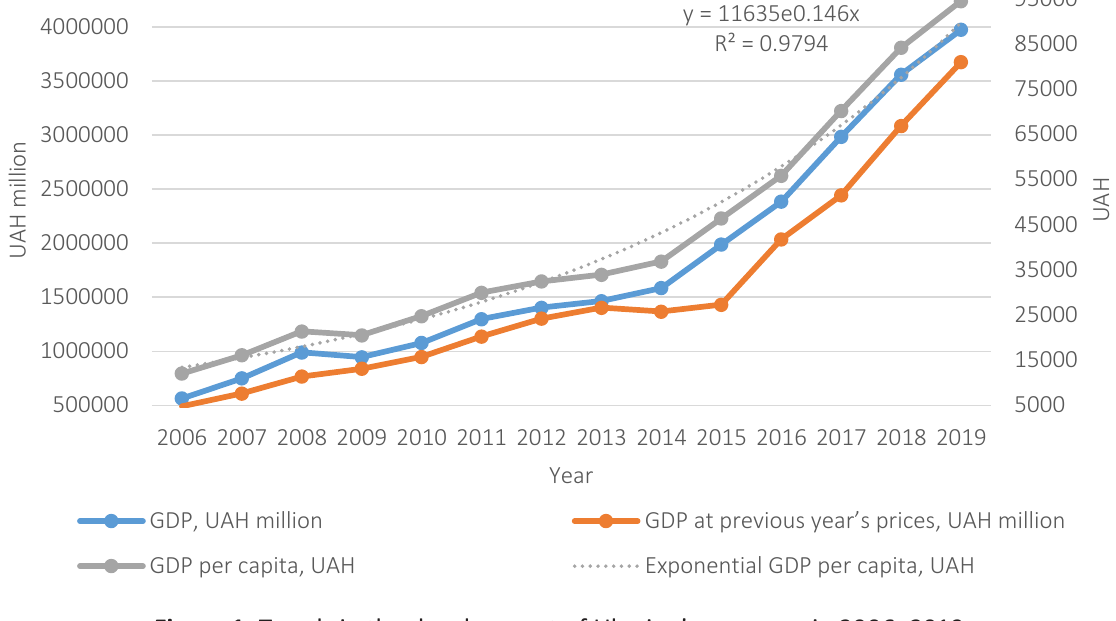
GDP at previous year’s prices, UAH million Exponential GDP per capita, UAH Figure 1. Trends in the development of Ukraine’s economy in 2006–2019